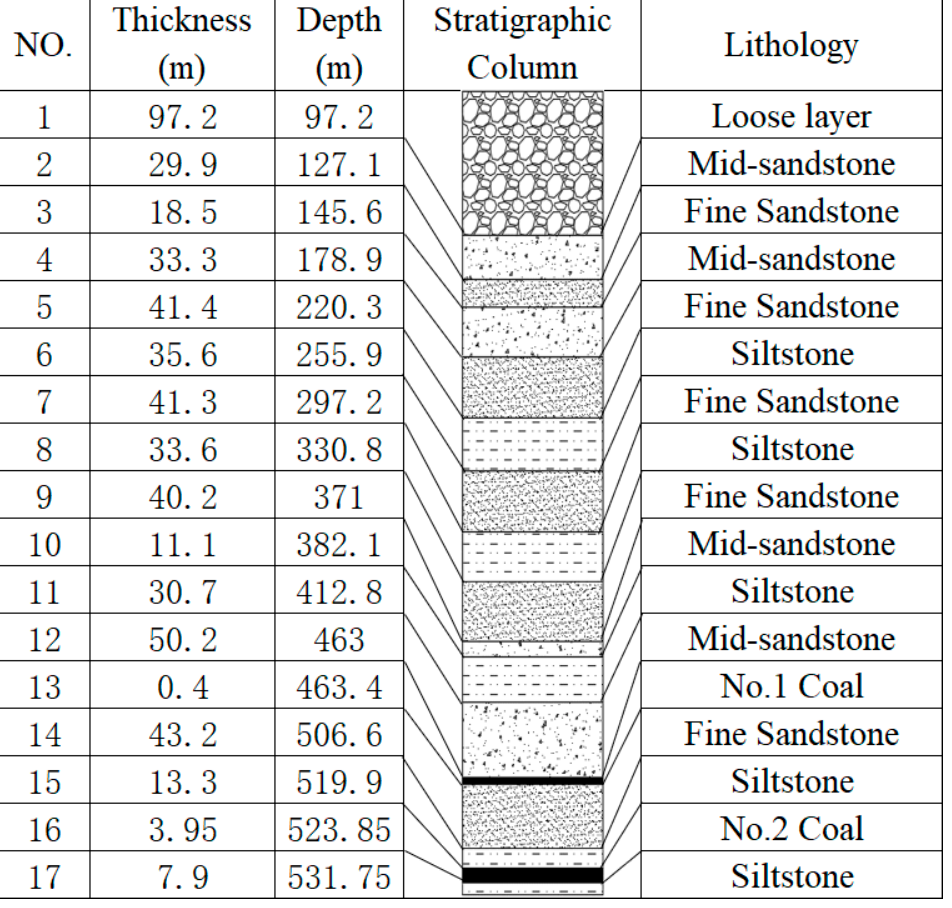
Figure 3. The stratigraphic sequence graph for the panel 132153. Four surveying lines were laid out above the panel to study the evolution of progres- sive surface subsidence before mining, performed from March 2018 to Jun 2019. A sche- matic diagram of pit location and surface movement monitoring stations are shown in Figure 4. There were 41 monitoring stations longitudinally (surveying line Z), whose se- rial numbers were assigned z1 to z41. The other three surveying lines (surveying lines Q, K 1 , and K 2 , with serial numbers q1 to q32, k1 to k6, and k7 to k14, respectively) involved 52 surveying stations in the traverse direction above the panel.